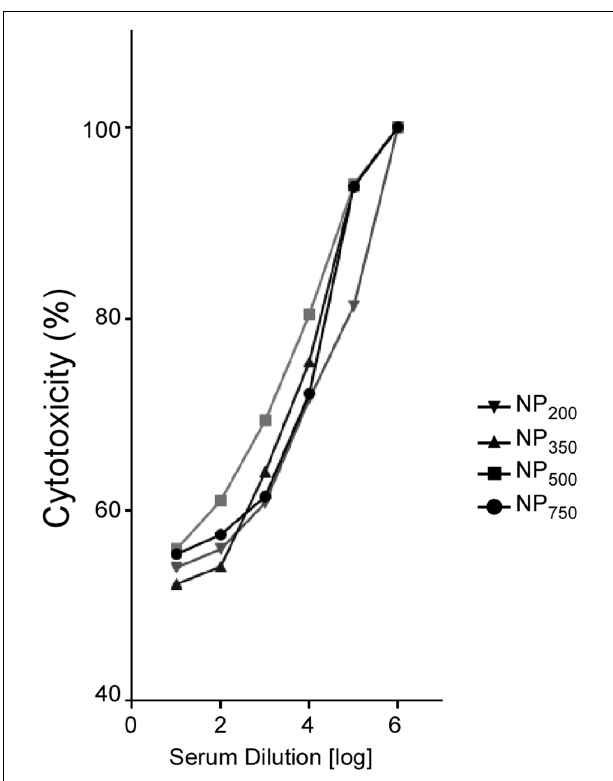
FIGURE 4 | In vitro evaluation of antibody-mediated neutralization of TcdB. Serum samples from immunized mice ( n = 5) were incubated with purified TcdB and then mixed with Vero cells. Cytotoxicity was assayed by lactate dehydrogenase (LDH) assay. No significant differences were detected between each immunized group. All data are representative of three independent experiments.